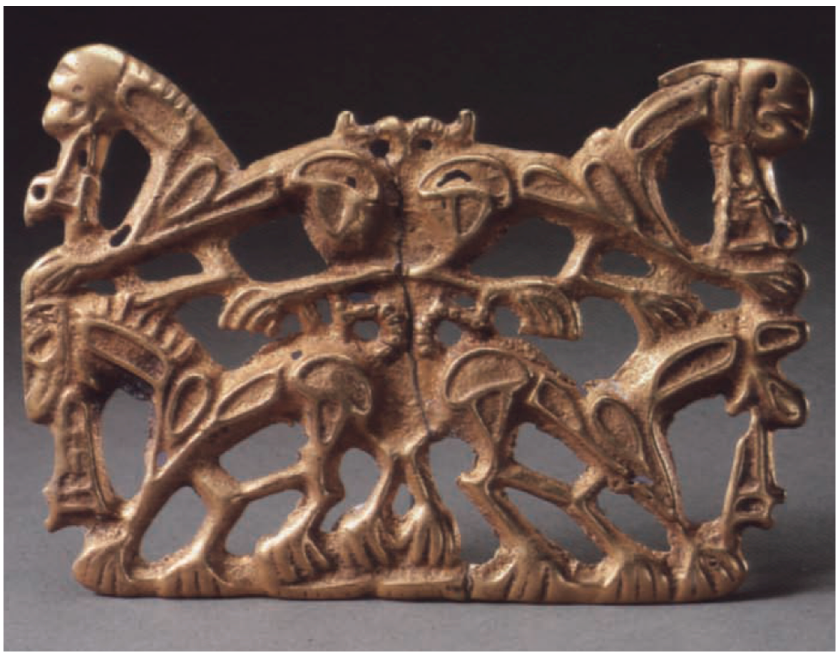
Figure 9. Plaque with four animals and inscription “Yituo Gold”, gold, excavated from Liangcheng, Inner Mongolia; after (Watt et al. 2004, p.